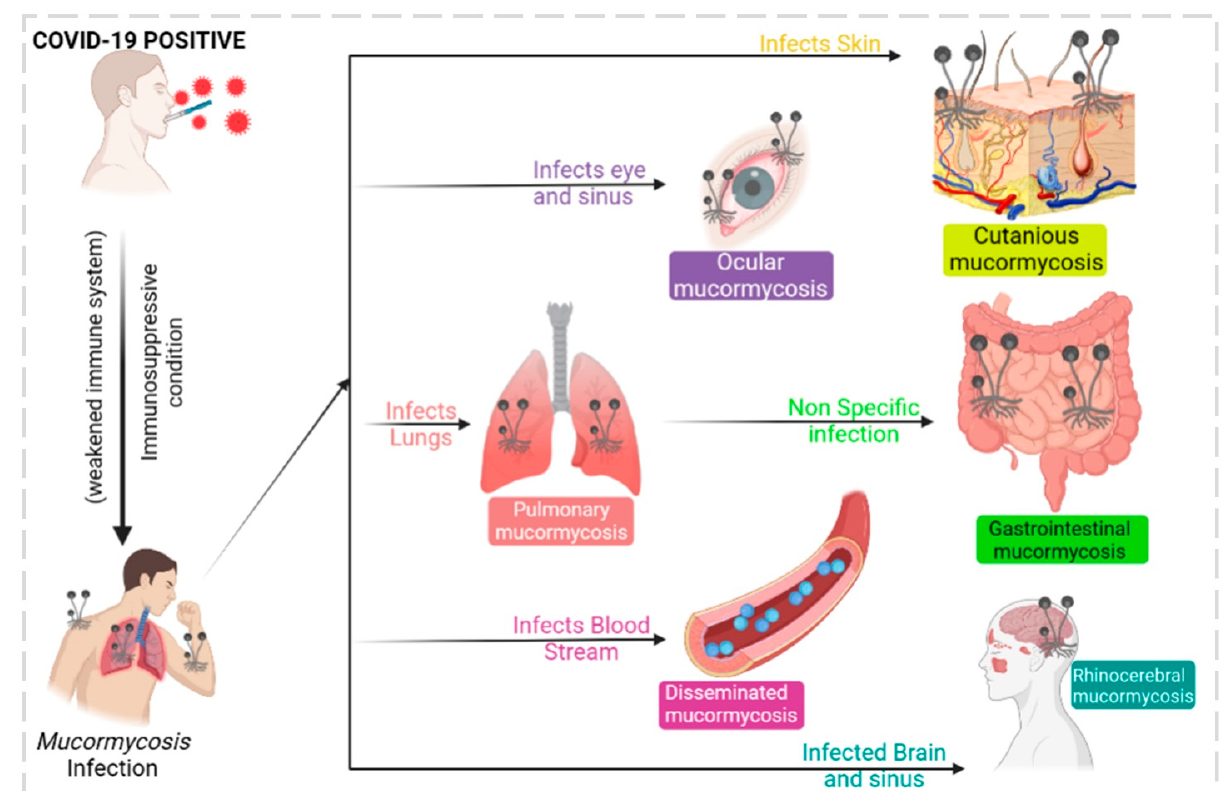
Figure 5. Mucormycosis infections of various types are associated with COVID-19.